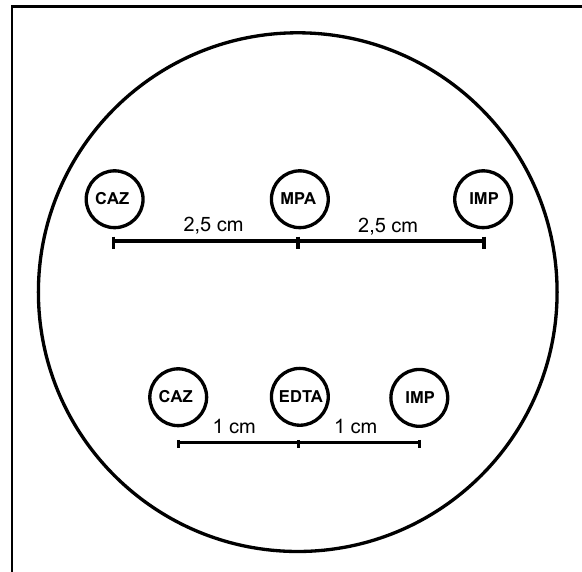
Figura 3 – Representação esquemática de distâncias, substratos e agentes quelantes sugeridos para a detecção fenotípica de amostras produtoras de MßLs